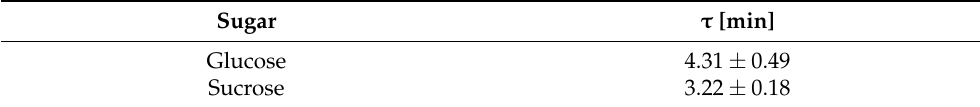
Table 1. Half-lives of glucose and sucrose.